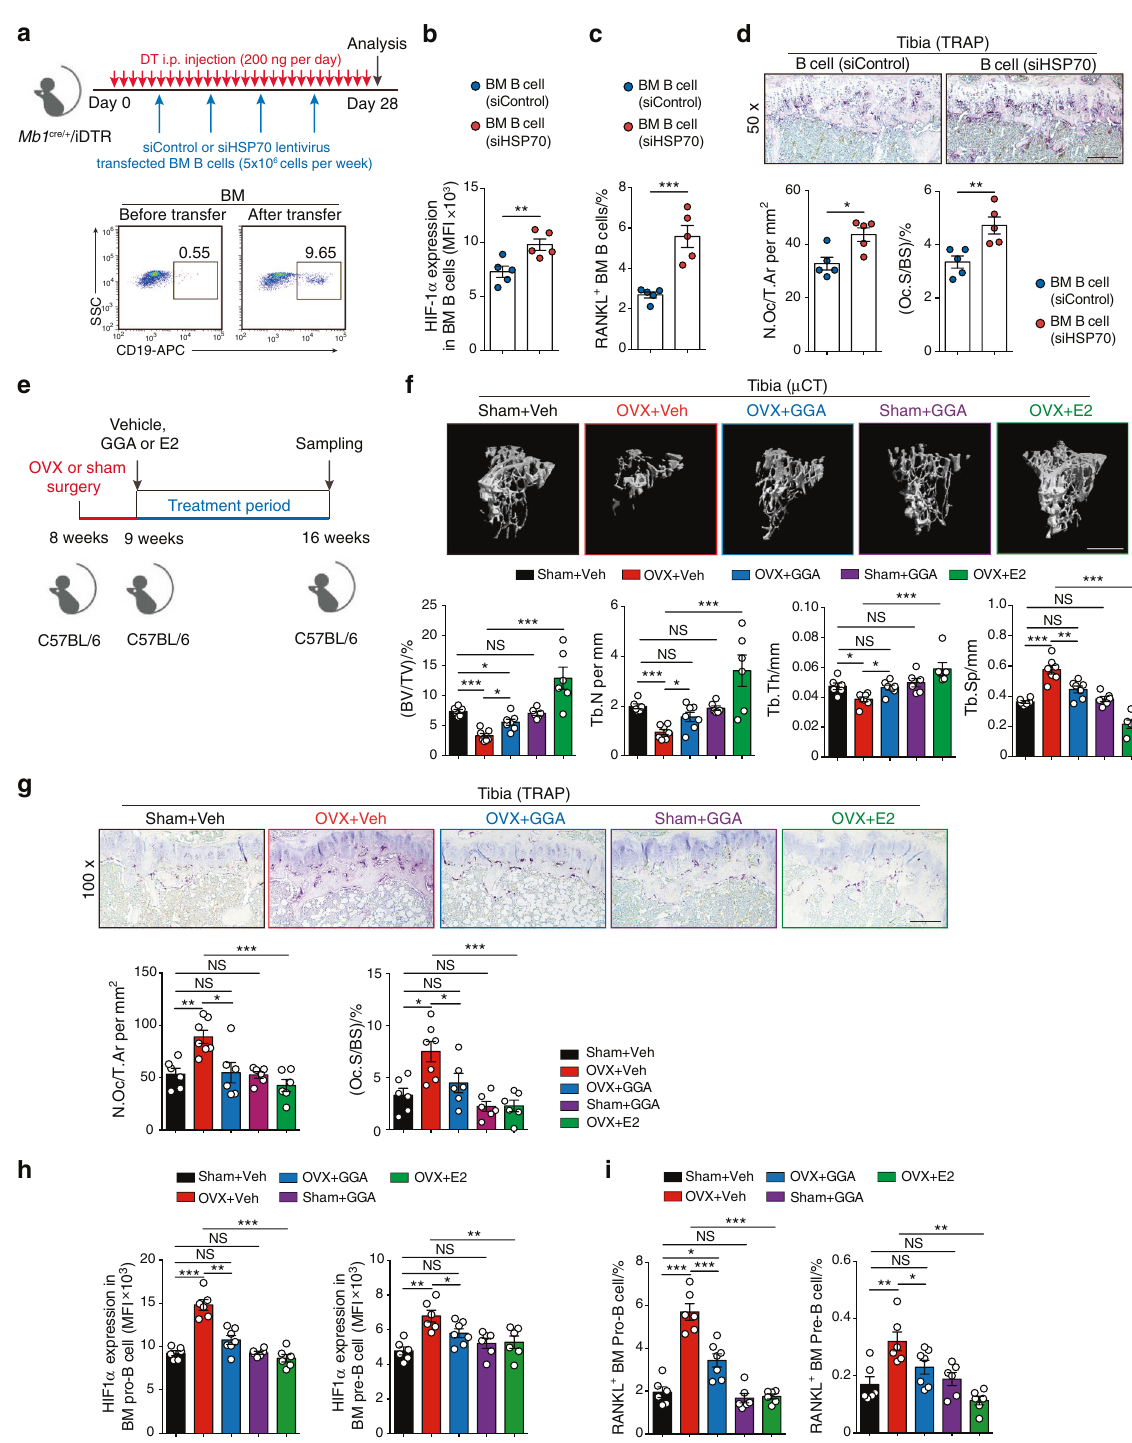
Fig. 5 The HSP70/HIF-1 α axis controls RANKL production in B cells and modulates osteoclastogenesis. a Scheme of adoptive transfer of siControl or siHSP70 lentivirus-transfected bone marrow B cells (5 × 10 6 cells per week) into female recipient Mb1 cre/ + /iDTR mice treated daily i.p. injection of DT (200 ng·d − 1 ) for 28 days. b HIF-1 α expression in B cells from the bone marrow of Mb1 cre/ + /iDTR recipient mice. c Frequencies of RANKL + B cells from the bone marrow of Mb1 cre/ + /iDTR recipient mice. d Representative TRAP staining and histomorphometry of N.Oc/T.Ar, Oc.S/BS were analyzed in tibia from mice shown in ( b ). Scale bars, 200 μ m. e Experimental scheme of pharmacological induction of HSP70 by GGA in osteoporotic mice. f Representative μ CT images of tibial trabecular bone and structural parameters (BV/TV, Tb.N, Tb.Th, Tb.Sp) in mice post sham surgery with vehicle (Veh) or GGA treatment, as well as OVX surgery with vehicle (Veh), GGA or estrogen (E2) treatment ( n = 6, 7). Scale bars, 500 μ m. g Representative TRAP staining and bone resorption parameters (N.Oc/T.Ar, Oc.S/BS) were analyzed in tibia from mice shown in ( f ) Scale bars, 100 μ m. h HIF-1 α expression in Pro-B and Pre-B populations from mice shown in (f). i Frequencies of RANKL + Pro-B and Pre-B populations from mice shown in ( f ). * P < 0.05, ** P < 0.01, *** P <